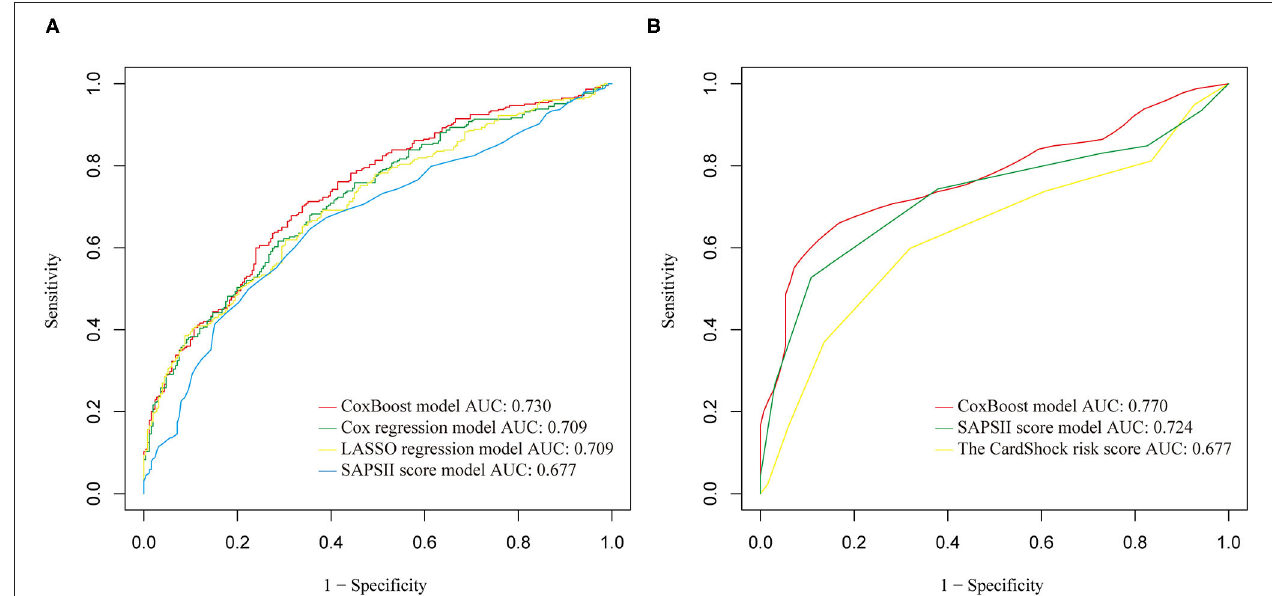
FIGURE 2 | (A) Receiver operating characteristic (ROC) comparison of training set models. (B) ROC comparison of validation set models.